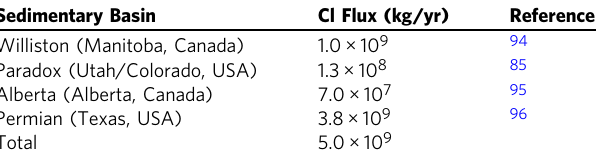
Table 1 Cl fl uxes from selected sedimentary basins containing evaporites in North